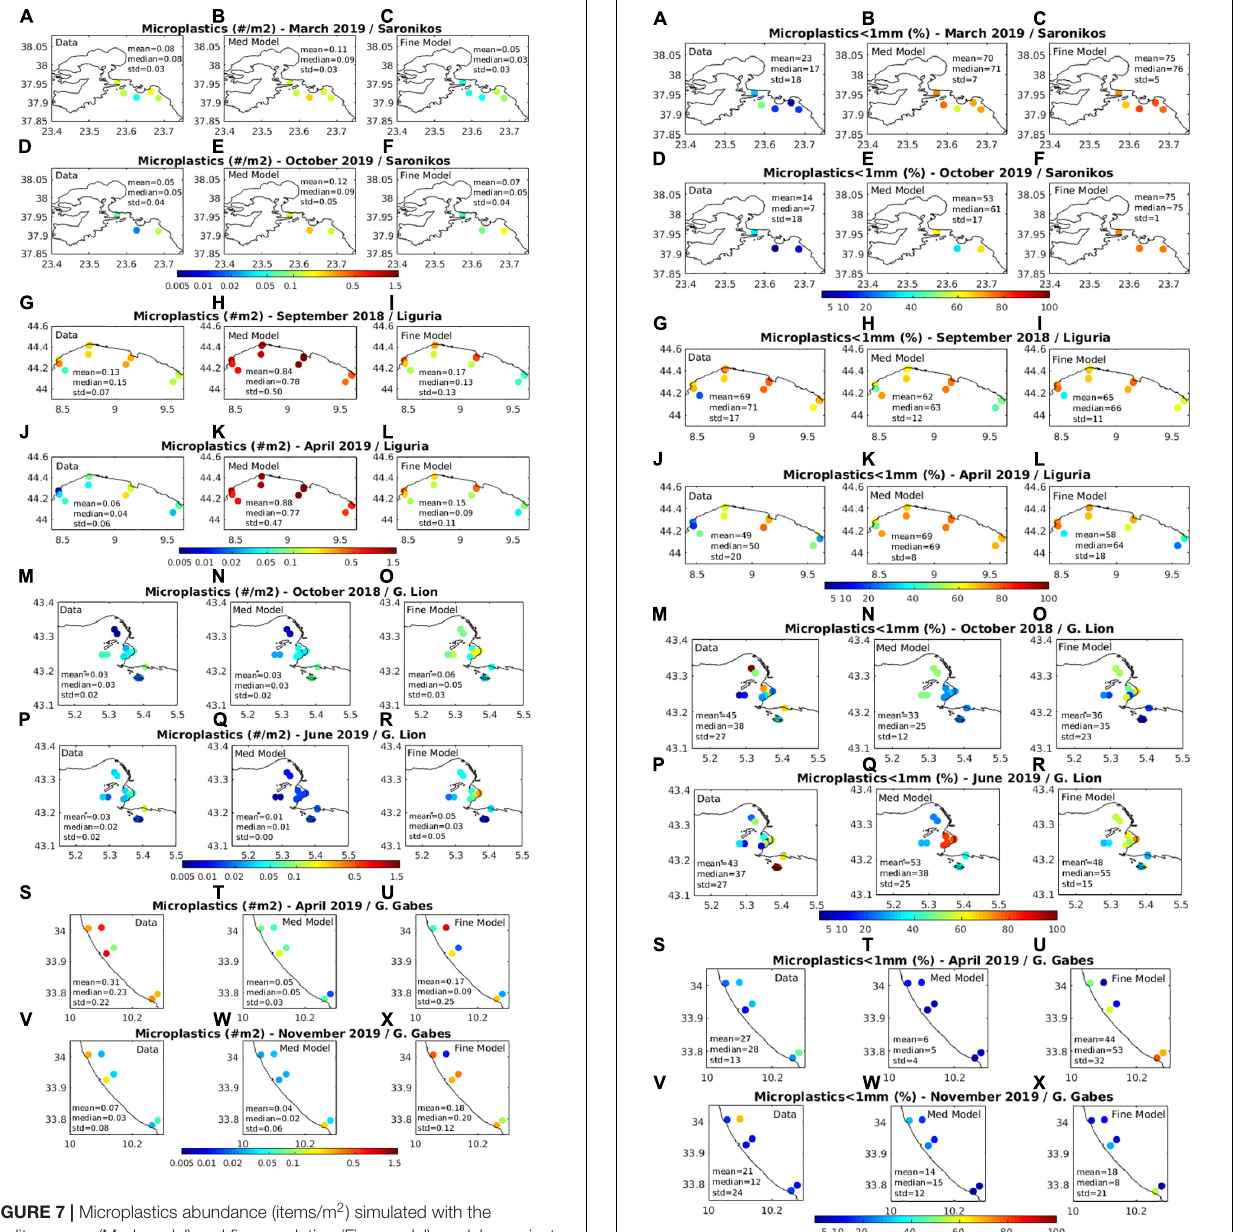
FIGURE 7 | Microplastics abundance (items/m 2 ) simulated with the Mediterranean (Med model) and fine-resolution (Fine model) models, against in situ data collected in the four key study areas, during the two campaigns. (A–F) Saronikos Gulf, (G–L) Ligurian Sea, (M–R) Gulf of Lion, and (S–X) Gulf of Gabes.